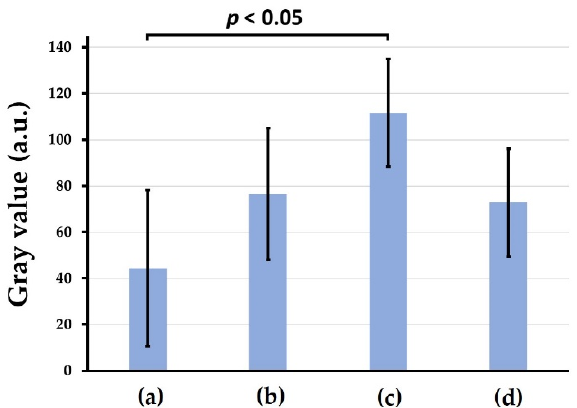
Figure 10. X-ray grey values of rat cranial bone defects with and without the three b-FGF-loaded granules: ( a ) defect only, ( b ) Col control + AG + b-FGF, ( c ) AI 20 min 5Cy Col/Hap + AG + b-FGF, and ( d ) AI 60 min 5Cy Col/Hap +AG + b-FGF. ( n = 6 for each).